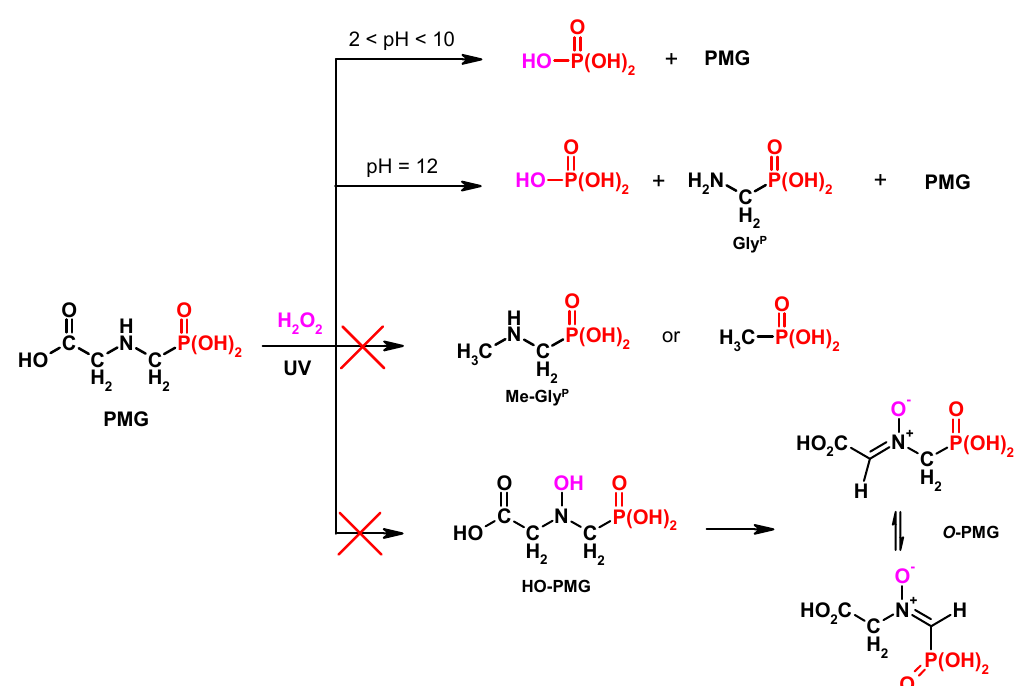
Figure 12. Possible degradation paths of PMG (reaction time: 48 h).